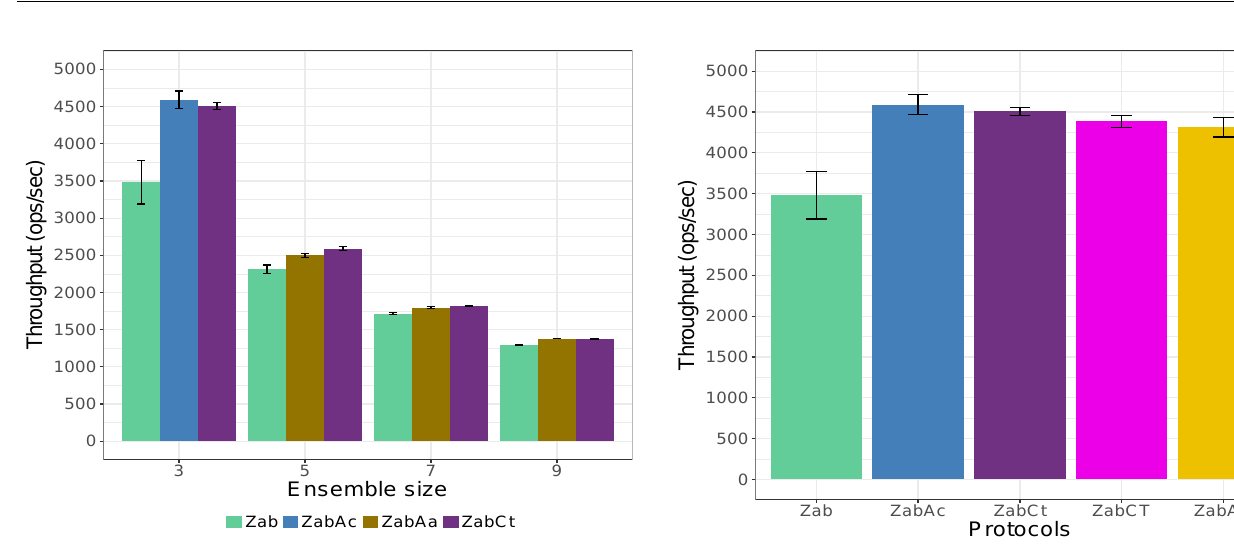
Figur e 5. Throughput comparison for WR = 100% and N =